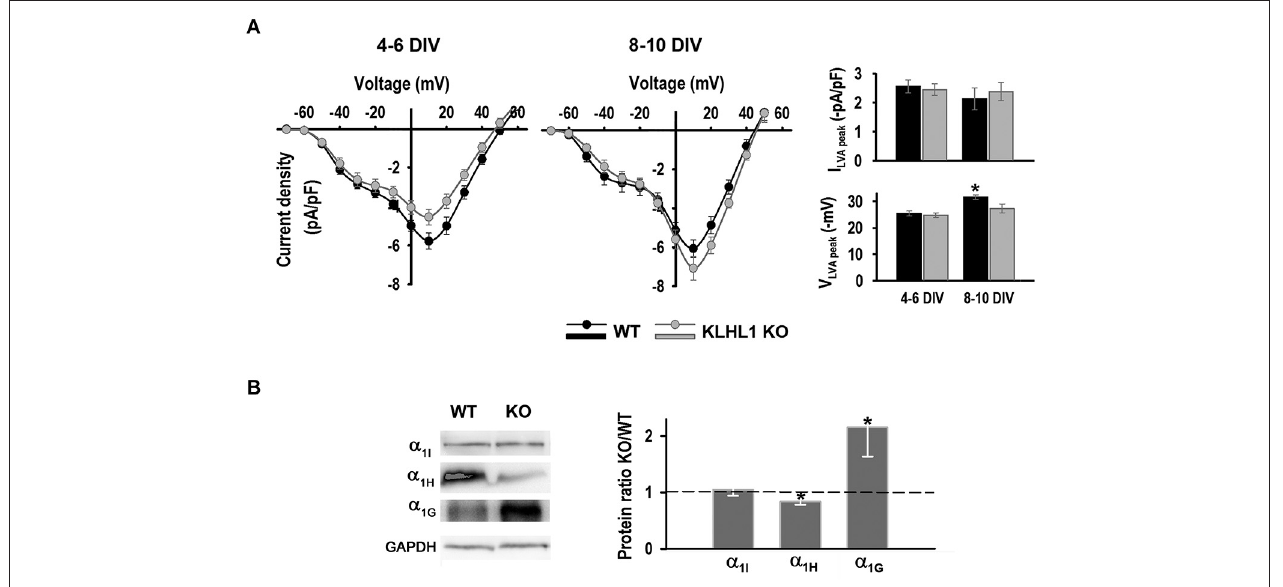
voltage. * p < 0.05, ANOVA. (B) Left panel : Examples of α subunit levels protein of Ca V 3.1, 3.2 and 3.3. Right panel : Quantification of protein ratios (KO/WT). * p < 0.05, paired Student’s t -test ( n = 7, 3, 5, from left to